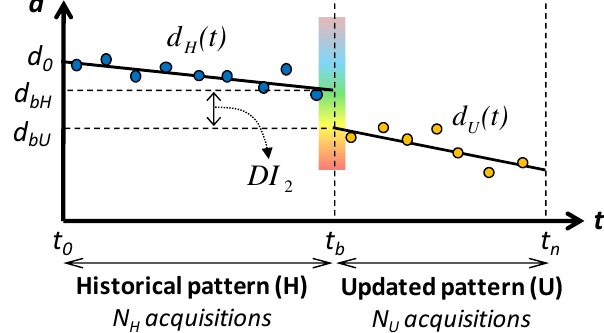
Fig. 3. Estimation of the Deviation Index DI 2 through the assess- ment of the step recorded between the intervals H and U Figure 3. Estimation of the Deviation Index DI 2 through the assessment of the step recorded 621 between the intervals H and U . 622